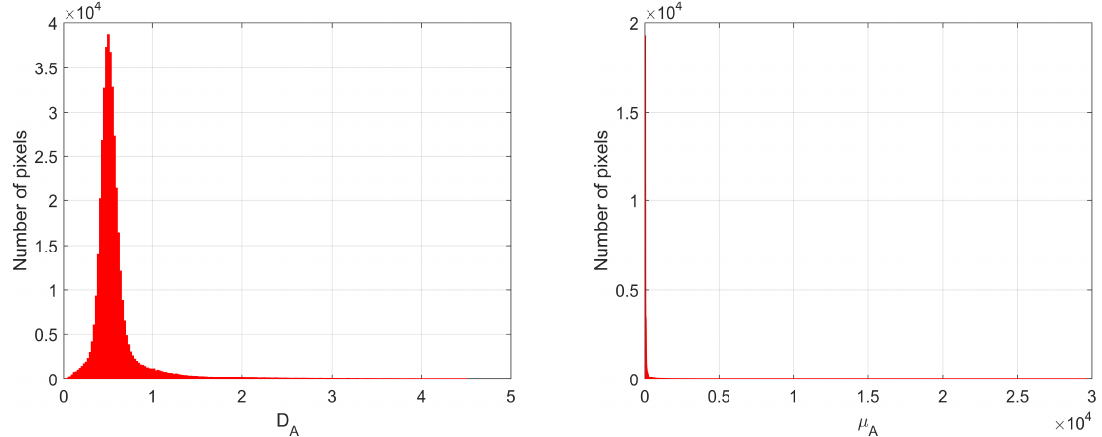
Figure 5. The distribution histograms of D A and µ A of the dataset in PS selection of Step 1.